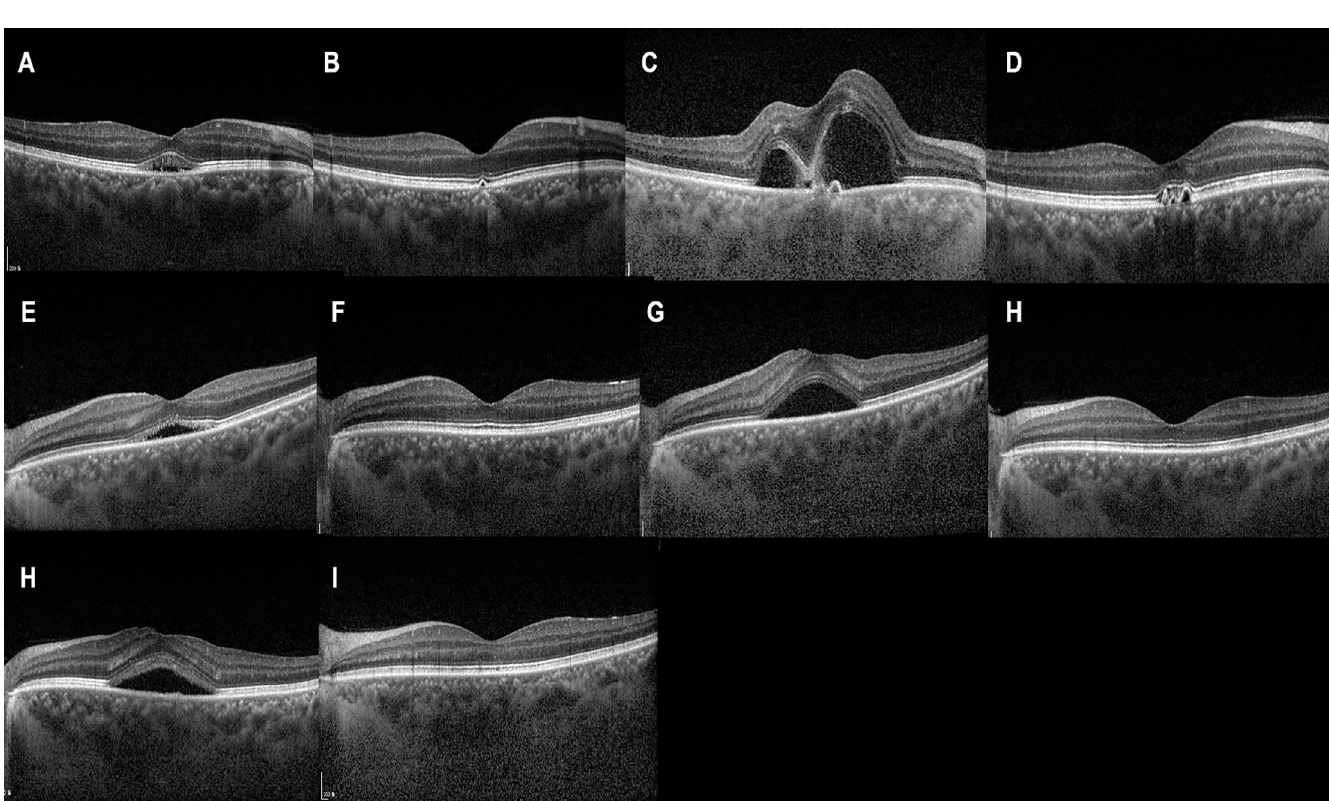
Fig 1. Image from 37-year-old male patient with central serous chorioretinopathy (CSC) in both eyes. The patient had a history of CSC 11 years prior that resolved spontaneously. He also had a recent recurrence of CSC in both eyes for 4 months and was referred to our hospital due to persistent subretinal fluid (SRF) in the right eye. The best-corrected visual acuity (BCVA) was 0.1 logarithm of the minimum angle of resolution (logMAR) in the right eye. (A) Subretinal fluid (SRF) at fovea with photoreceptor ellipsoid zone blurring was noted. Hyper-reflective dots in SRF was also noted. (B) A single intravitreal bevacizumab injection (IVBI) led to complete resolution of SRF, but small retinal pigment epithelial detachment (PED) was noted. (C) After 11 months, CSC recurred showing profuse subretinal fluid, and two more IVBIs were performed to resolve the SRF (D). (E) SRF also developed in the left eye, and the BCVA was 0.1 logMAR at the time of recurrence. After the first IVBI, SRF resolved completely (F), however, SRF recurred after 1 month (G). (H) Two more IVBIs were needed in the left eye to resolve the SRF, and (I) CSC recurred after 18 months. (J) Two IVBIs were needed to resolve the SRF of the recurred